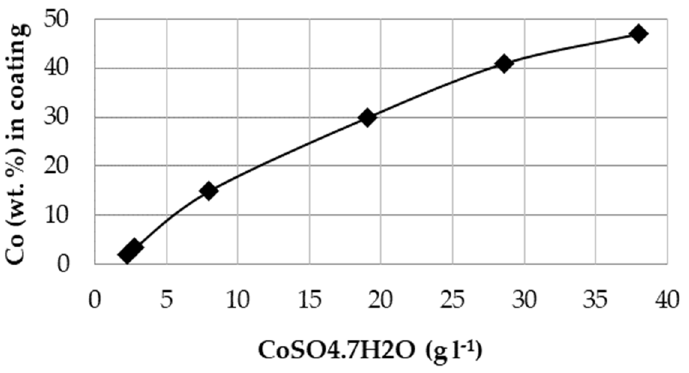
Figure 1. Dependence of Co wt. % in coatings on the cobalt sulphate concentration in galvanic bath at a current density of 2 A dm − 2 .